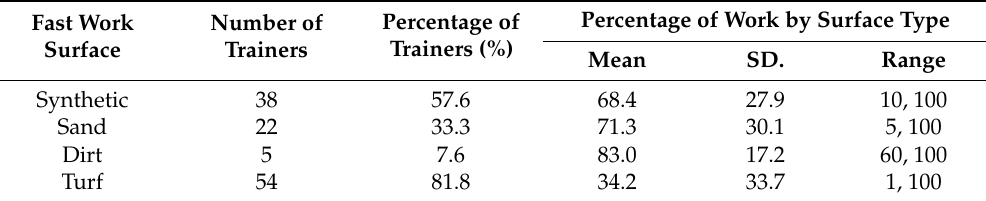
Table 2. Percentage of Thoroughbred trainers (n = 66) using each surface type for fast workouts, and the mean percentage of workouts spent on each surface used in Victoria,